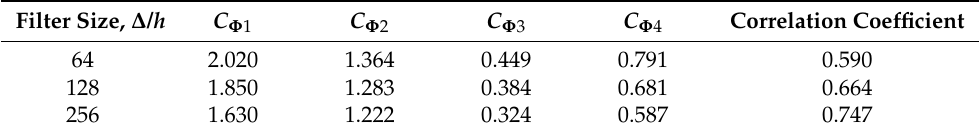
Table 2. Coefficients in the constant coefficient model (7).